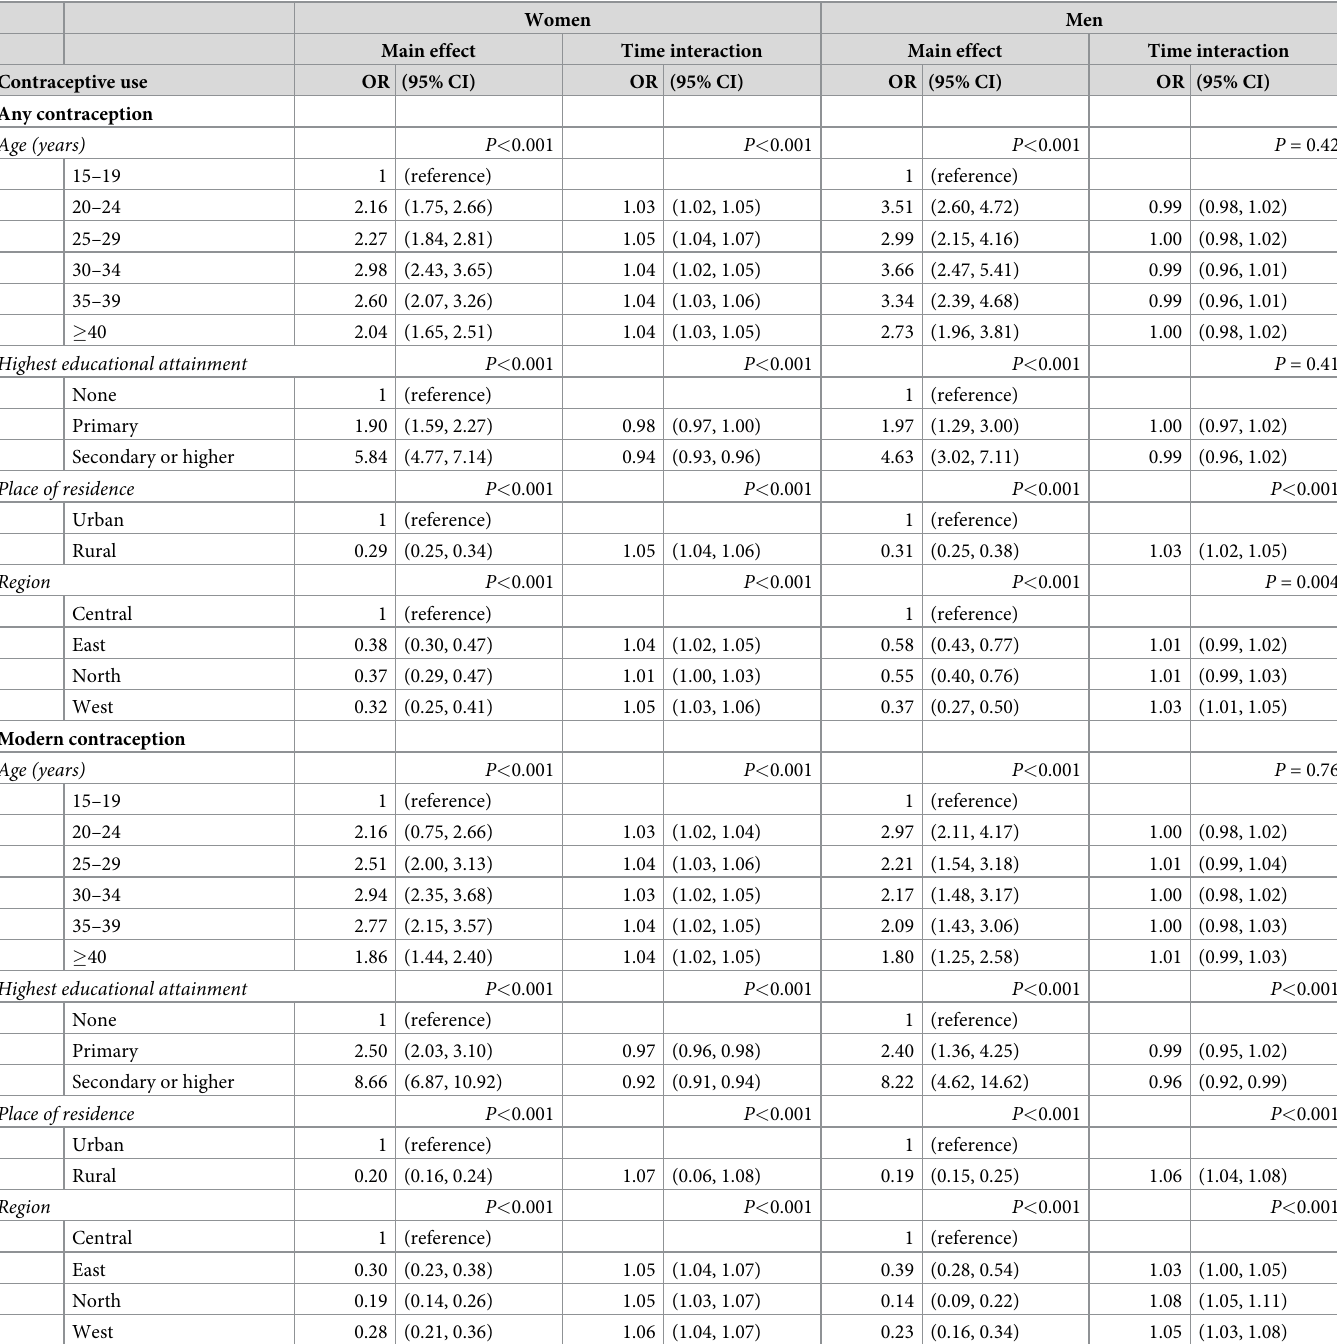
Table 2. OR together with associated 95% CIs of using any and modern contraceptive method for women and men in Uganda over the years